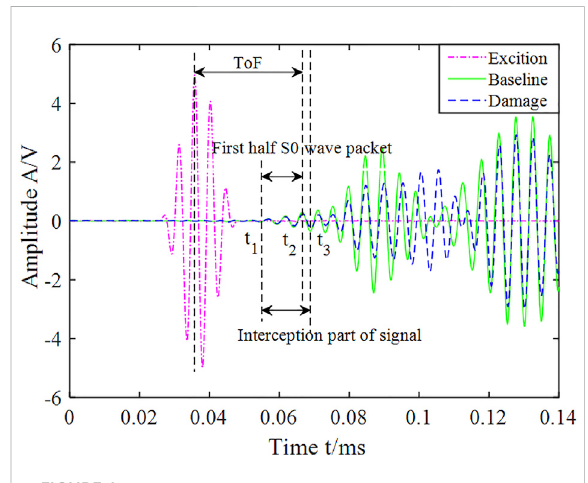
FIGURE 1 Schematic diagram of the Lamb wave signal